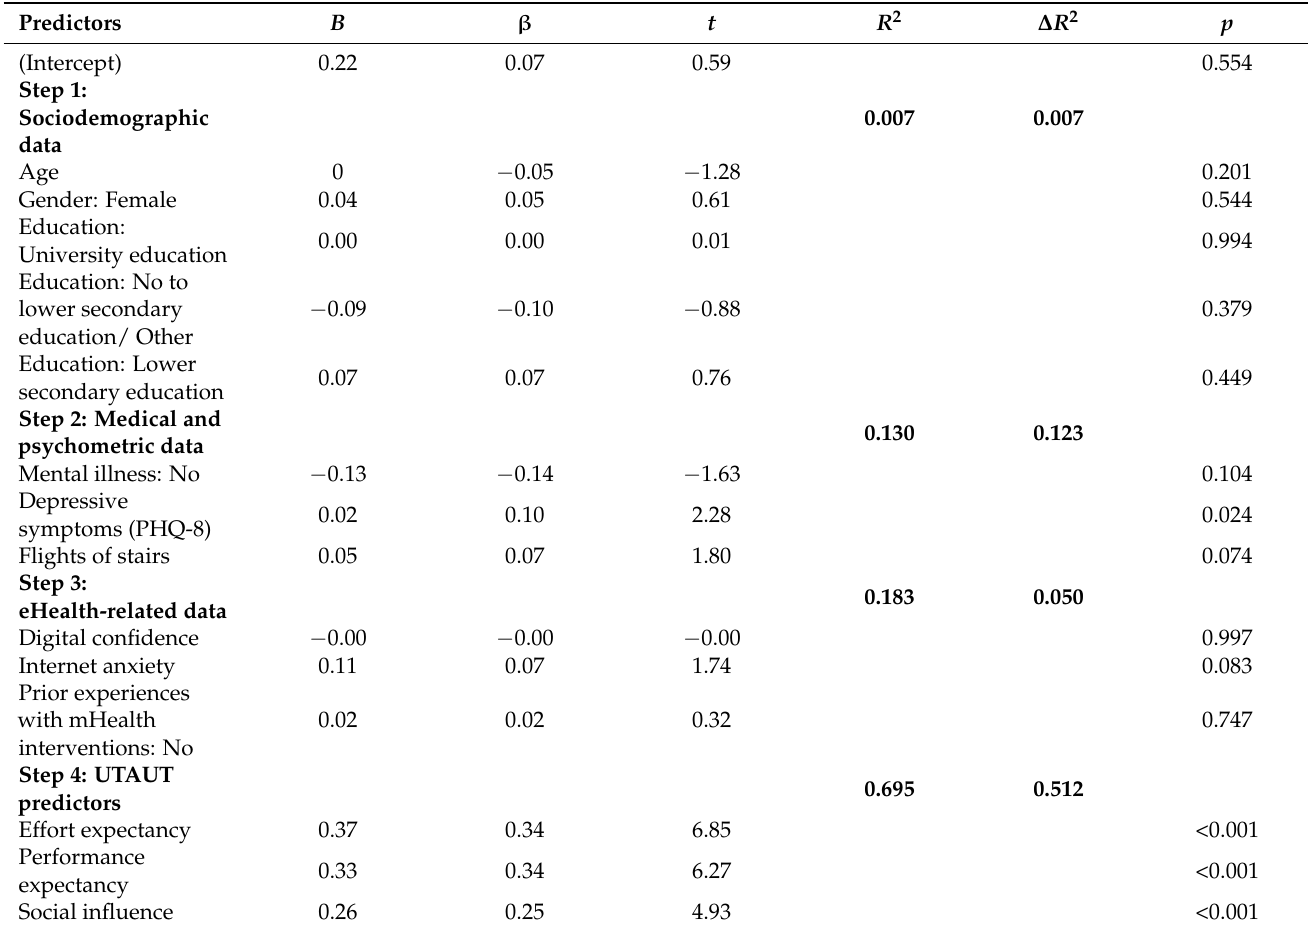
Table 2. Hierarchical regression model of